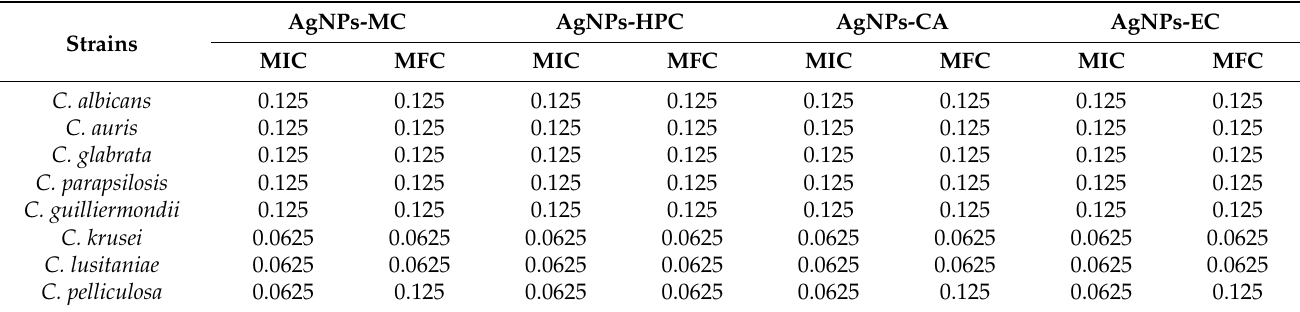
Table 4. Antifungal activity (MIC, MFC; mM) of AgNPs.